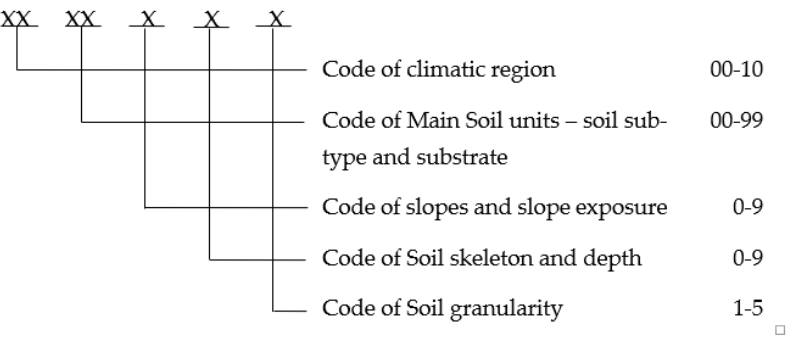
Figure 3. VSEU scheme.